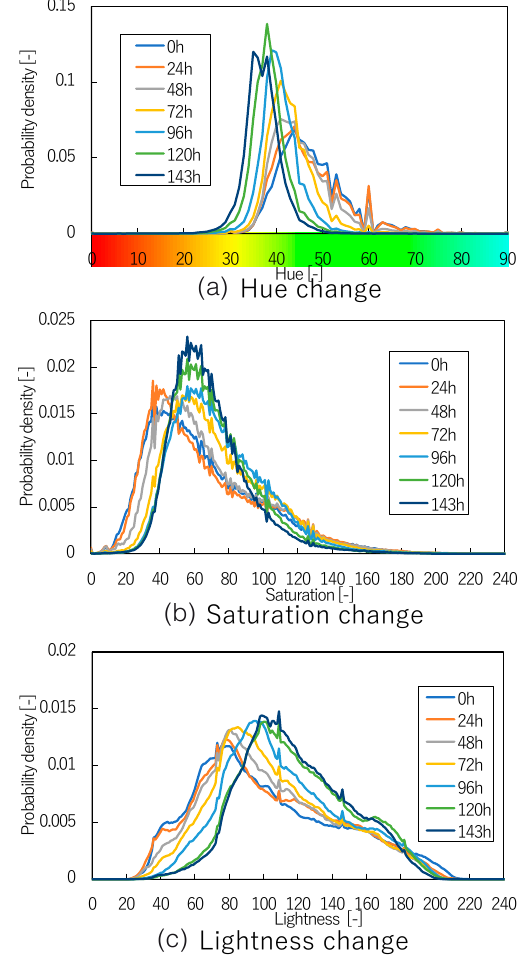
Fig. 6: The change of color distribution.